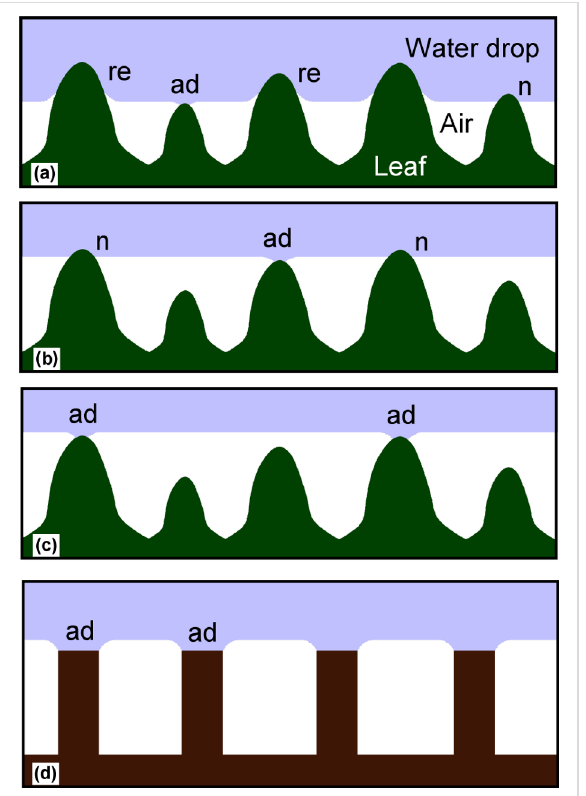
Figure 4: The contact between water and superhydrophobic papillae at different pressures. At moderate pressures the water intrudes into the space between the papillae, but an air layer remains between water and epidermis cells (a). The superhydrophobic surface of the papillae causes a repellent force (‘re’). When the water recedes, then the papillae lose contact one after the other (b, c). At a certain water level, the meniscus is flat and the force is neutral (‘n’). Just prior to the separation an adhesive force (‘ad’) arises at the almost horizontal area of the papilla tip, which is small on tips with intact wax crystals and larger when the wax is damaged or eroded. On artificial superhy- drophobic structures with equal height (d) the adhesive forces during water receding occur simultaneously at all contacts.